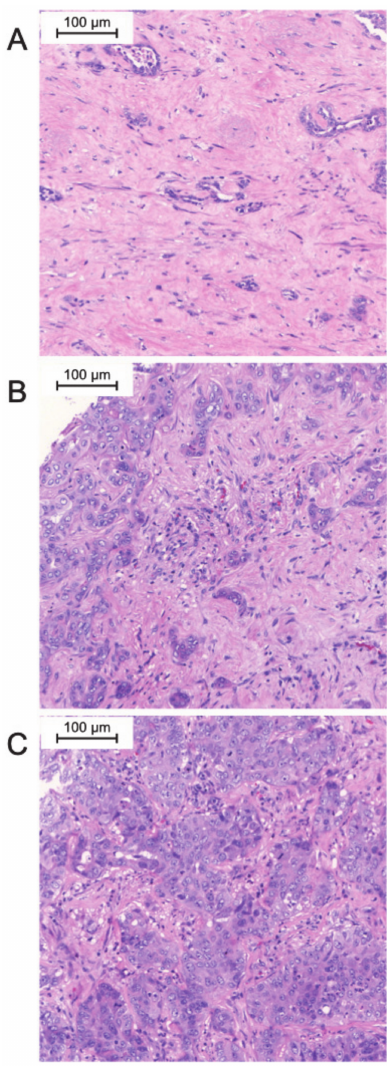
Figure 1. Examples of high-resolution microscopy images of biliary tract cancer with low ( A ), intermediate ( B ), and high ( C ) TIN density (hematoxylin and eosin staining). The demographics of the three groups were similar regarding age (mean age 67 in the LD group vs. 66 in the ID group vs. 67 in the HD group) and gender (58% females and 42% males in the LD group vs. 42% females and 58% males in the ID group and 50% females vs. 50% males in the HD group). Tumor stage distribution differed significantly in the three groups, since in the LD group the most represented T stage was T3 ( N = 17, 55%). In the ID group, the majority of the patients had T1–T2 tumors ( N = 10, 83%) and 17% ( N = 2), also in the HD group, all had a comparatively smaller T1–T2 primary tumor ( p = 0.012). The rate of N+ tumors was also significantly different in the three groups. In the LD group, 71% ( N = 22) had a positive nodal status as compared with 25% ( N = 3) in the ID group and 50% ( N = 4) in the HD group ( p = 0.025). No difference was